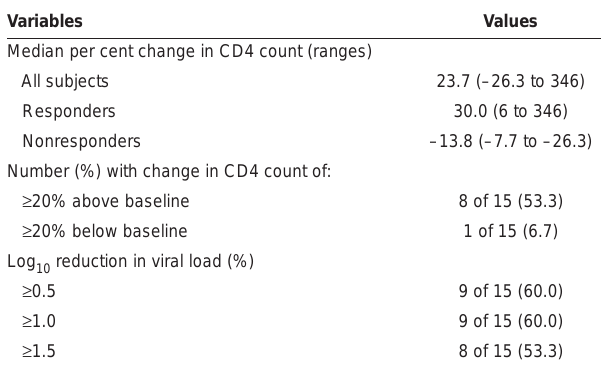
TABLE 1 Baseline characteristics of subjects at enrolment